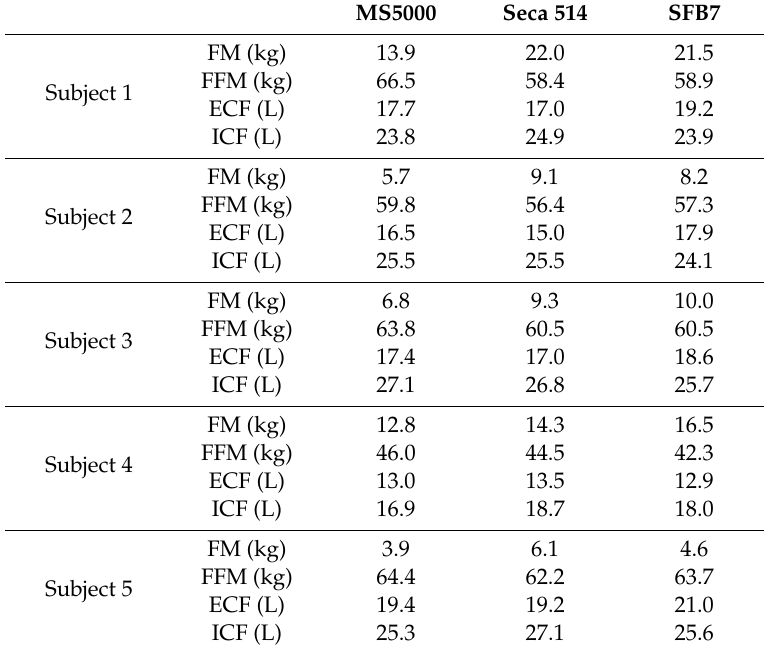
Table 4. Comparison of Body Composition Parameters Determined by the Commercial